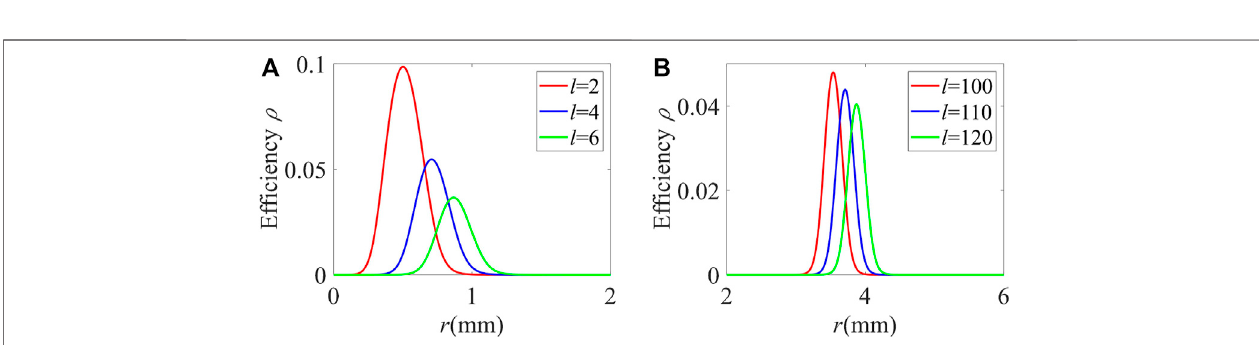
FIGURE8| FWMef fi ciency ρ versus radius r fordifferentvaluesoftheTCs. (A) and (B) correspondtothecasesoflow-orderTCsandhigh-orderTCs,respectively. Other parameters are the same as in Figure 6 .